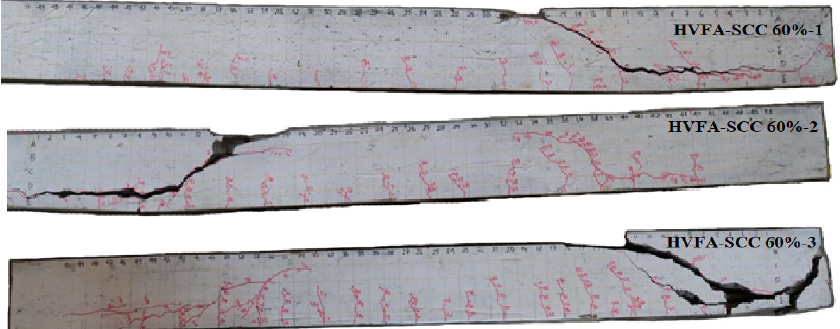
Figure 7. Crack pattern of 50% HVFA ‐ SCC concrete at ultimate shear force.